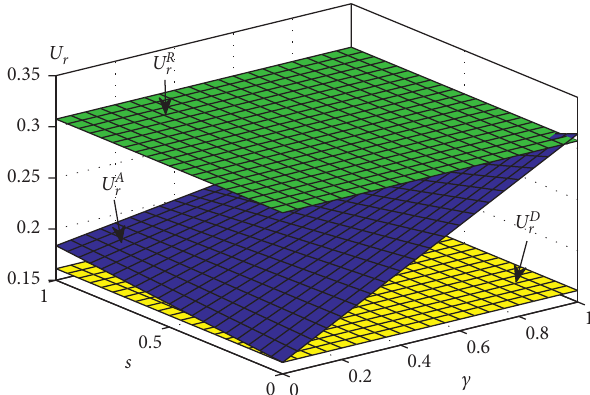
Figure 5: Impact of the commission fee and retailer’s fairness concerns on the retailer’s